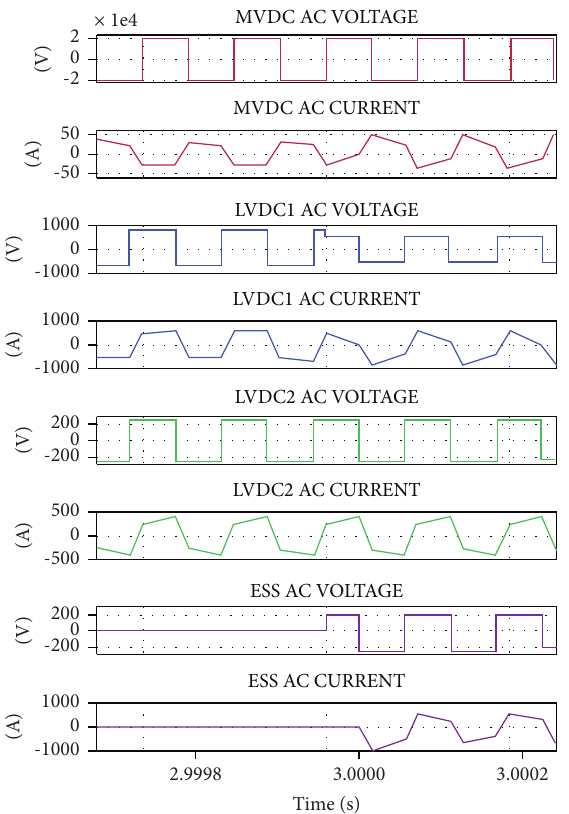
Figure 18: Mode 3 to mode 4 HFL waveforms. Table 4: Experimental parameters.